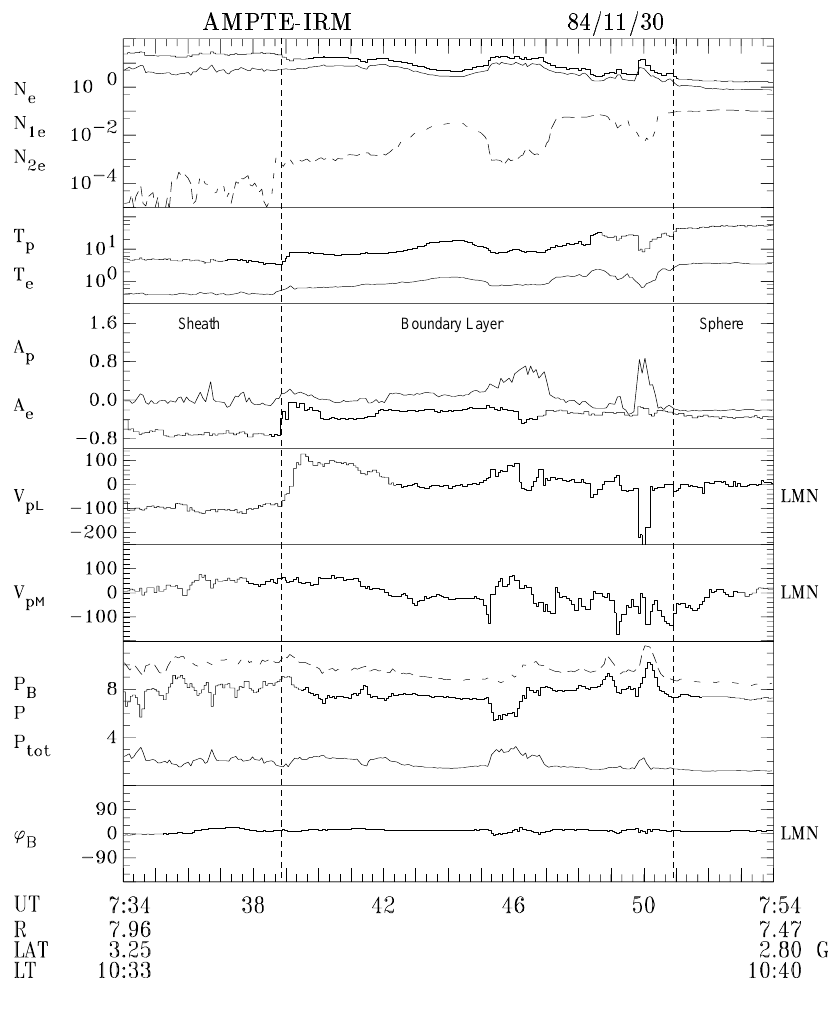
Fig. 8. Overview of the magnetopause pass on 30 November 1984. The format is the same as in Fig.